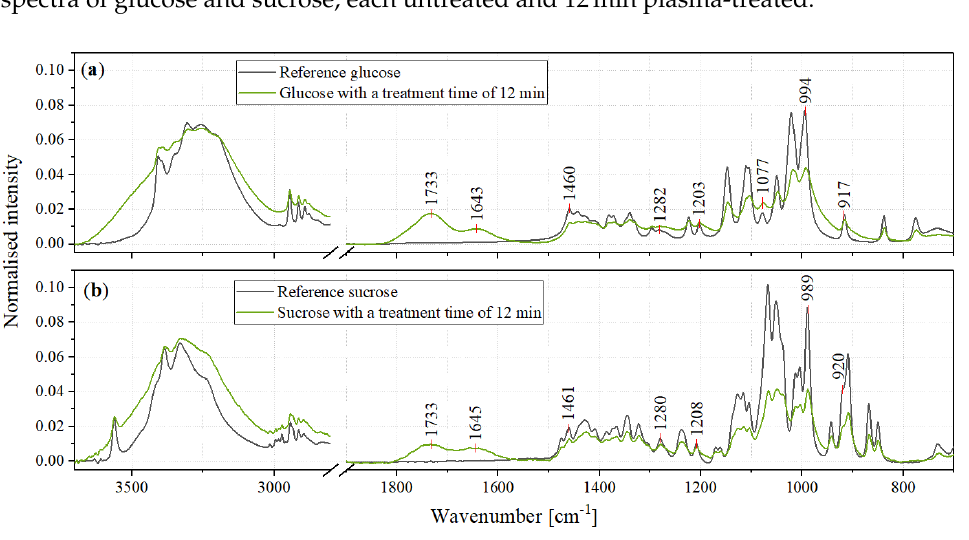
Figure 5. FTIR spectra of untreated (black) and 12min plasma-treated (green) sugars: ( a ) shows this for glucose and ( b ) for